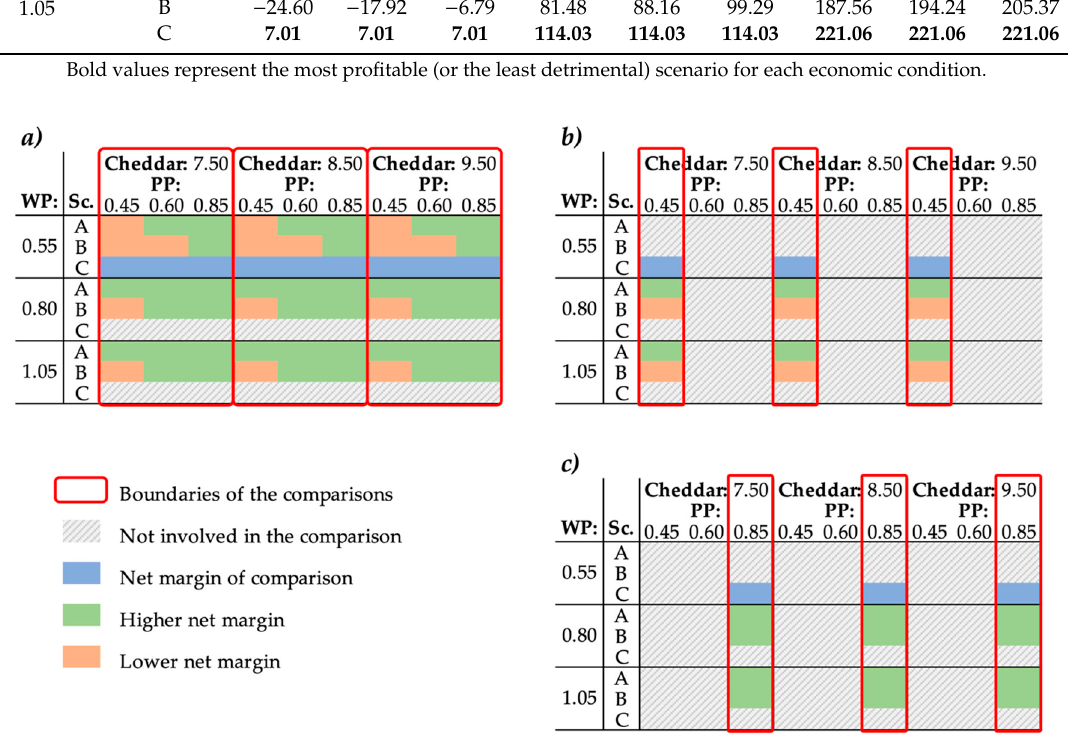
Figure 5. Comparisons of the net margin generated per ton of raw milk received as a function of the